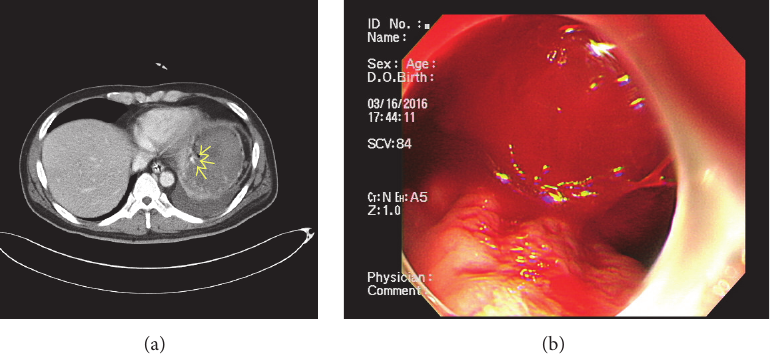
Figure 2: (a) An abdominal CT scan revealed bleeding gastric varices. (b) Esophagogastroduodenoscopy revealing bleeding from fundal gastric varices. Endoscopic hemostasis failed because of large clots and ongoing